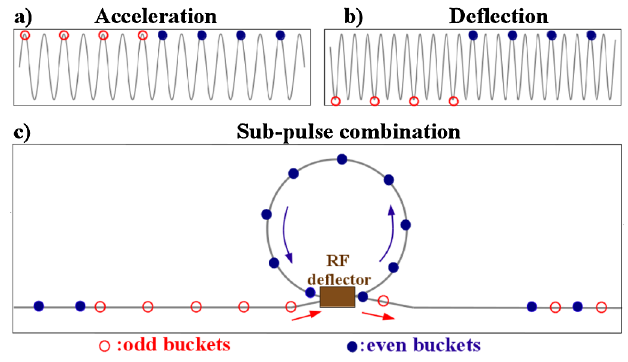
FIG. 4. Wake potentials of a Gaussian bunch with 3 mm bunch